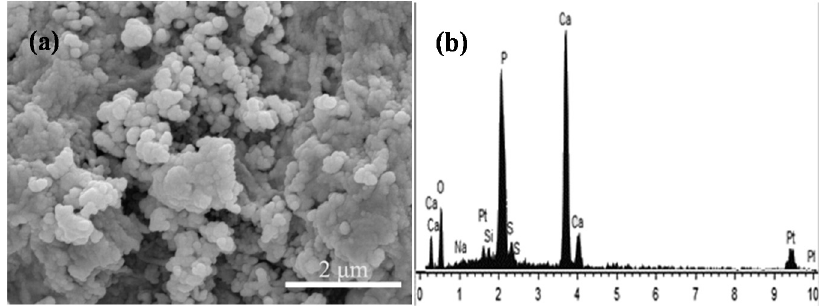
Figure 9. The immersion of CaSO 4 scaffolds with 45S5 bioglass in SBF for four days: ( a ) morphology and ( b ) Energy dispersive spectroscopy (EDS) analysis. The arrow indicates the crystals for EDS analysis on the composite scaffolds.